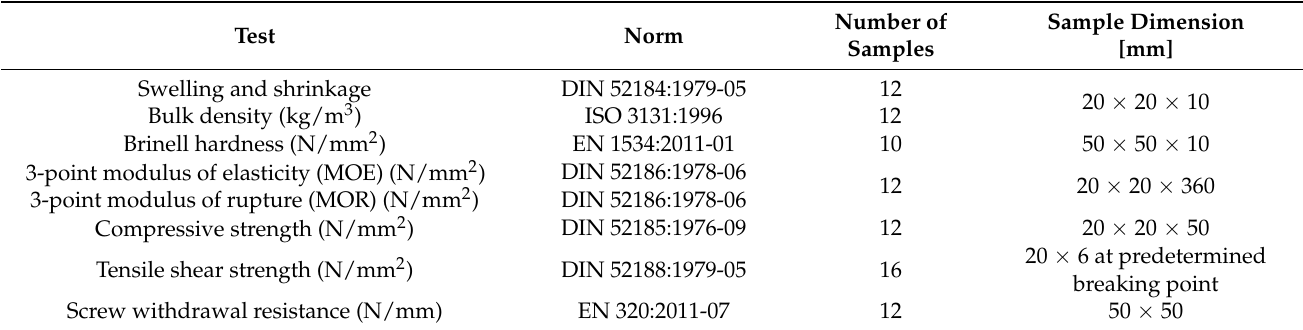
Table 2. Test preparation for Paulownia wood samples: norms, dimensions, and number of testing